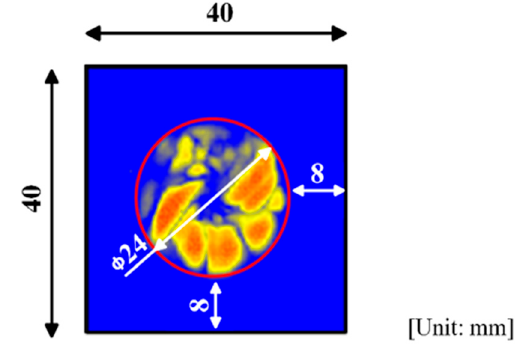
Figure 11. Image of ultrasonic C-scan inspection.